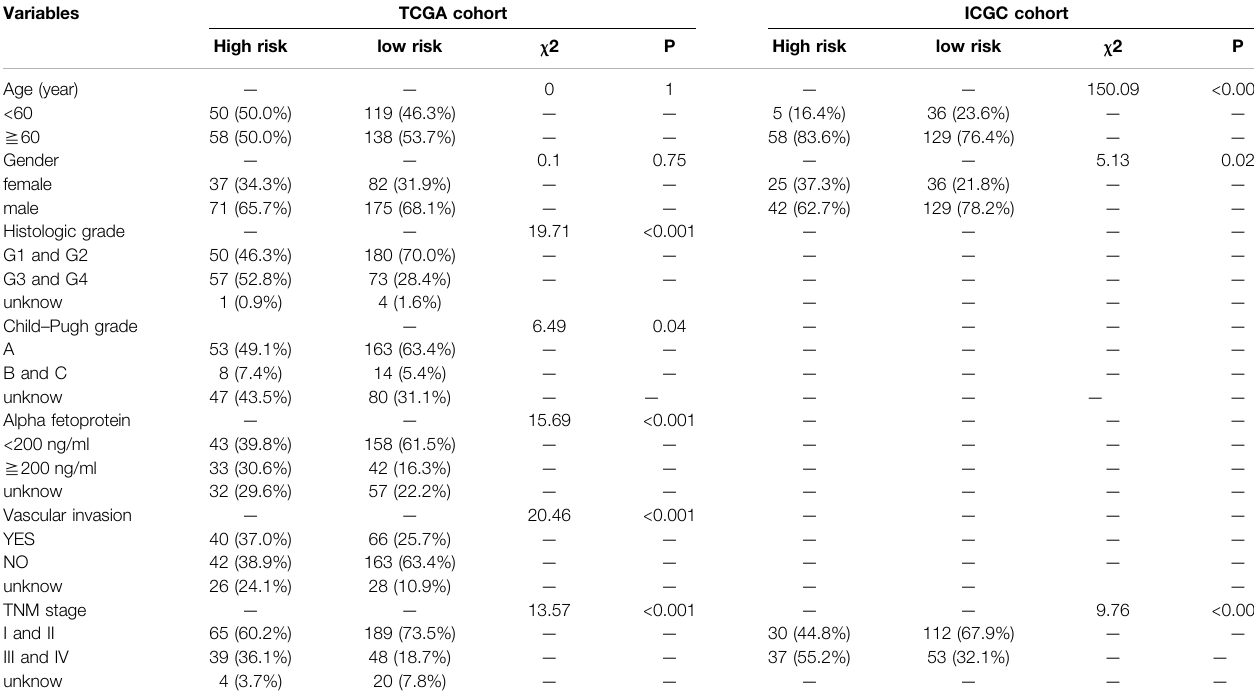
TABLE 1 | Baseline characteristics of the patients in different risk groups.